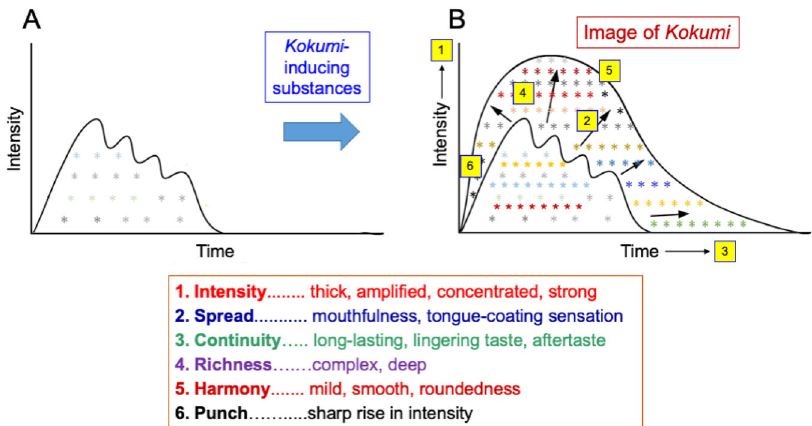
Fig. 1 A theoretical representation of kokumi with six related characteristics. Under the in fl uence of kokumi substances, food with umami and other taste substances ( A ) becomes more palatable with the kokumi attributes ( B ). This image corresponds to stages C and D in Fig.